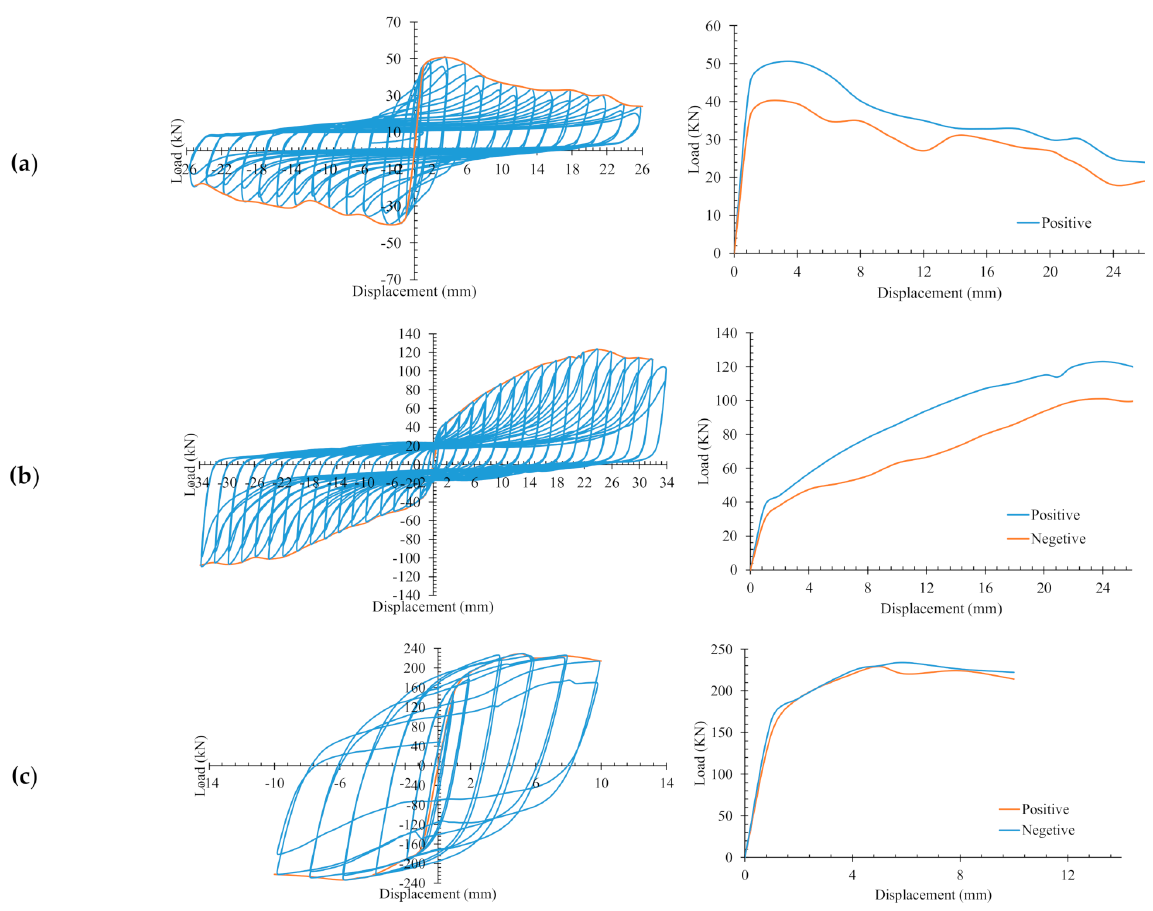
Figure 7. Damper: ( a ) M_P; ( b ) M_P_St; ( c ) S_P_St. Comparing the hysteresis curves of specimens, Figure 8 reveals that M_P had lower strength and energy_dissipating capability than other models. However, a comparison of S_P_St and M_P_St showed that, by connecting the cross plate to the web plate, higher strength and lower ultimate displacement was achieved in contrast to specimens without connected plates.